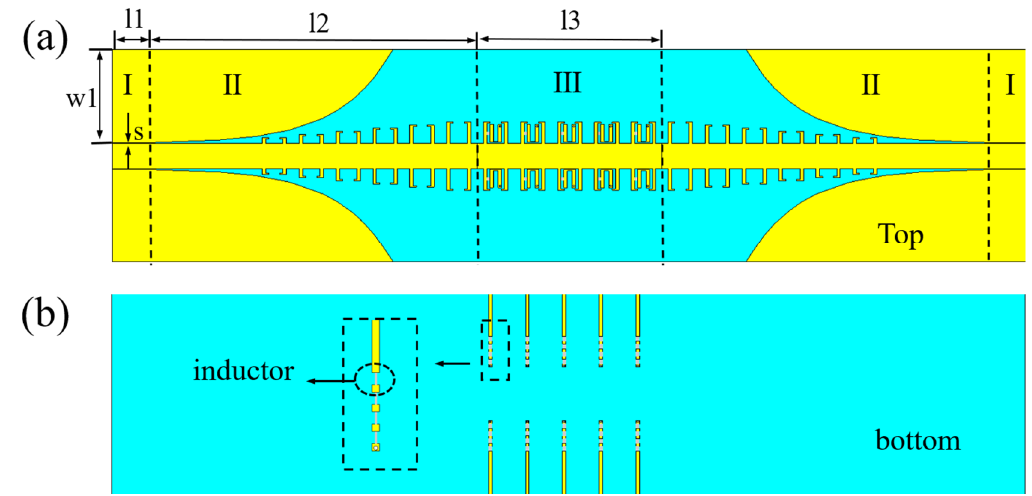
Figure 3. The schematic of the proposed SSPPs dynamic modulation filter. ( a ) The top view. ( b ) The bottom view.